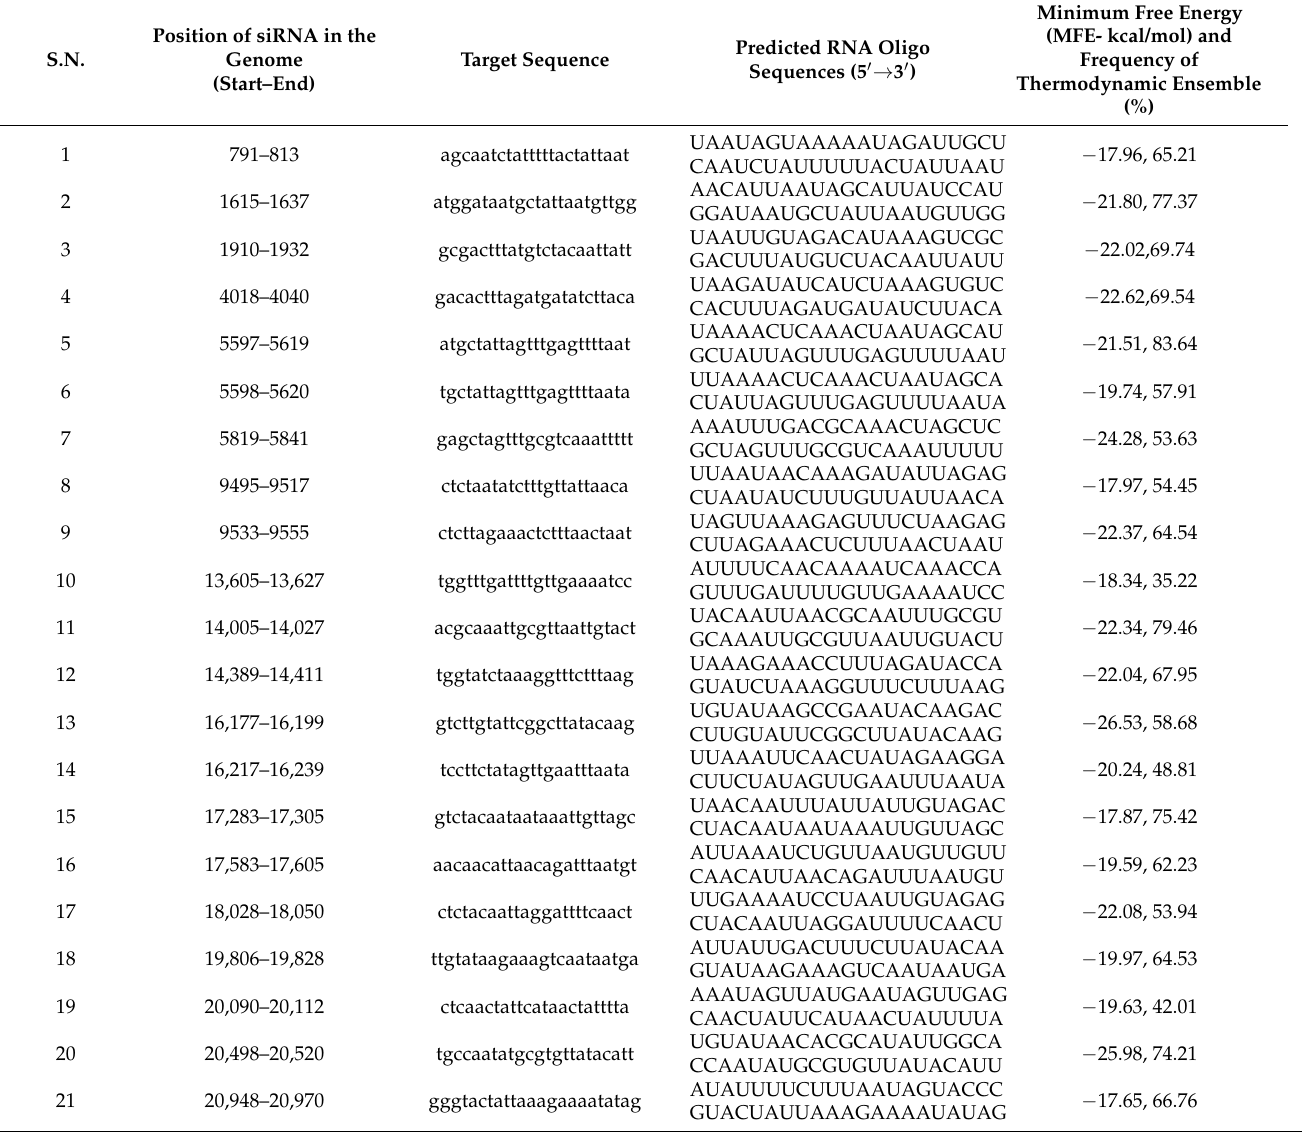
Table 1. List of predicted siRNAs from MERS-CoV ORF1ab gene (KF958702).